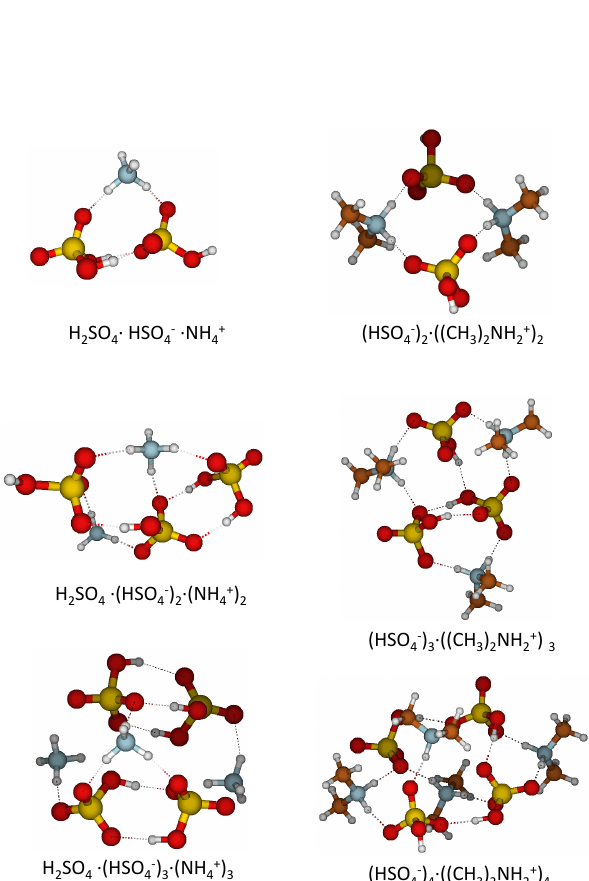
Fig. 1. The structure of some of the most stable cluster found in this work. Yellow, red, white, blue, and brown spheres represent sulfur, oxygen, hydrogen, nitrogen and carbon atoms,